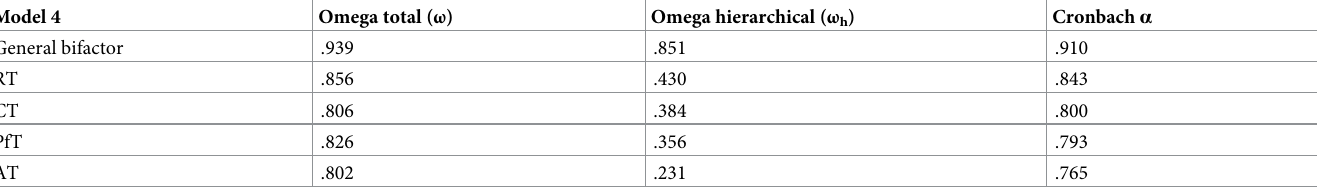
Table 4. Alpha and omega internal consistency for the bifactor ESEM of the RTSQ (Model 4).